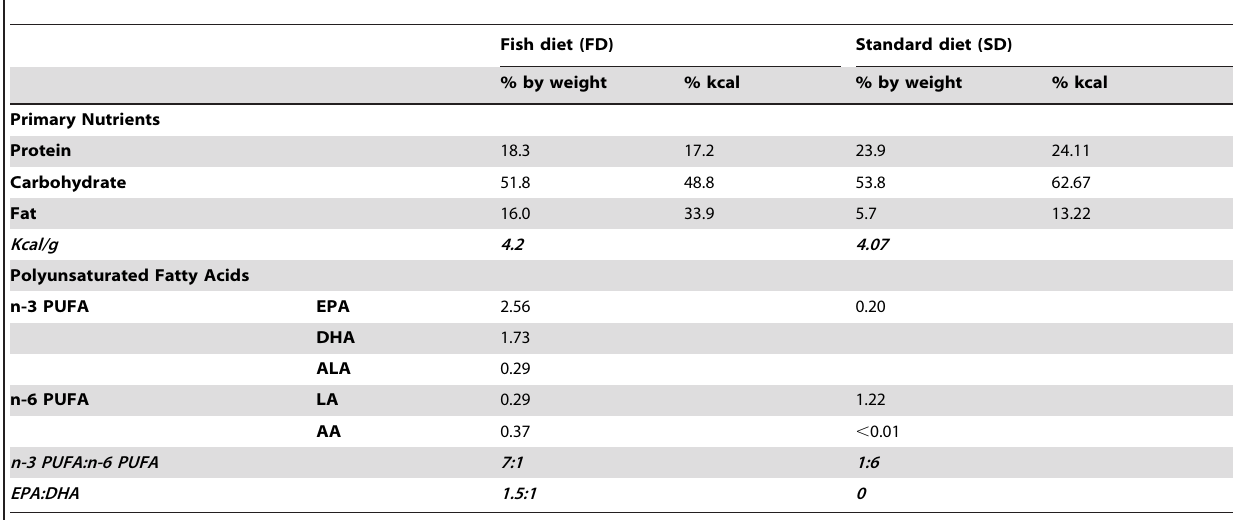
Table 1. Compositions of the primary nutrients and n-3 PUFA and n-6 PUFA in two diets of interest.